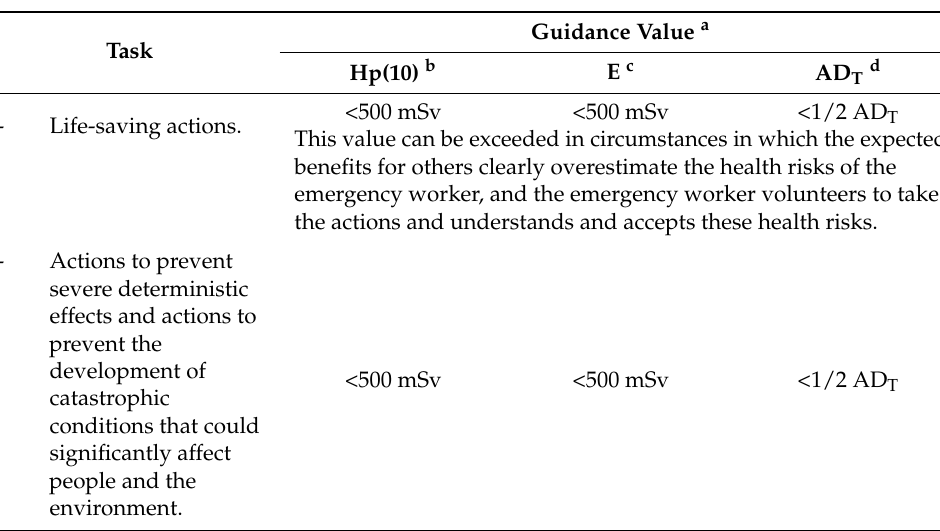
Table 2. Guidance values for restricting exposures of emergency workers from IAEA [17]—see Appendix B for a,b,c,d’s